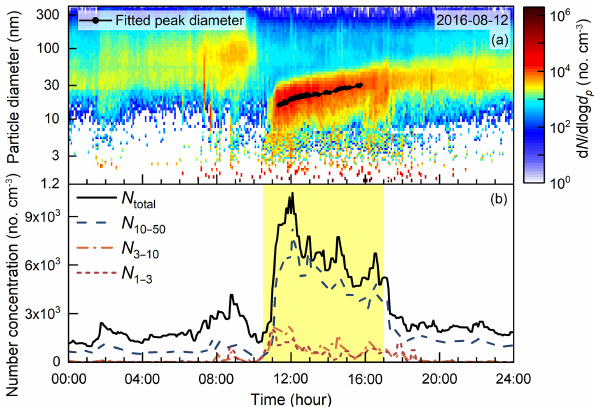
Figure 3. The temporal evolution of the aerosol size distribution observed at the Lulang River valley on 12 Aug 2016. (a) The con- tour plot of aerosol size distributions. The black dots with the solid line are the peak diameters of the fitted lognormal distributions. The growth rate of the new particles was determined as the average slope of the fitted peak diameter over time. (b) The time series of the num- ber concentration of 2nm–10µm ( N total ), 10–50, 3–10, and 1–3nm (reported by the PSM) particles. The period of time governed by the valley breeze is shaded with light yellow (see Fig.